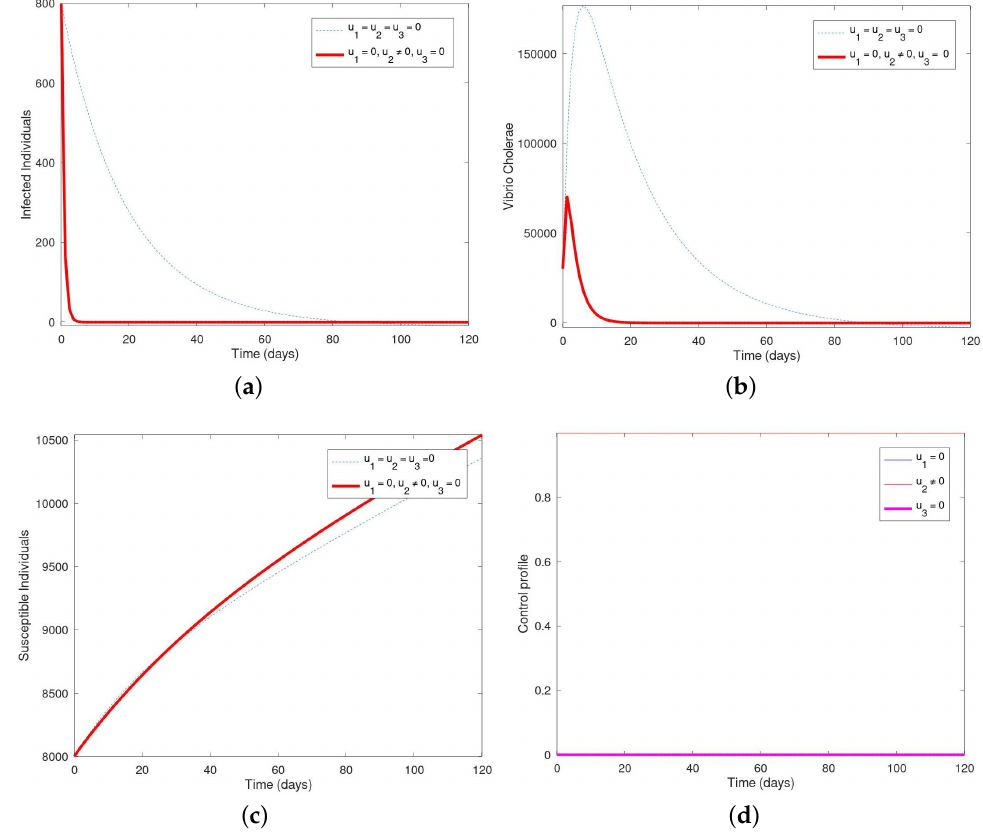
Figure 2. Simulation showing the population of ( a ) infected, ( b ) vibrio cholerae, ( c ) susceptible and ( d ) the control profile with ( u 2 ) , only. In Figure 2a, the population of the infected human decreases sharply and by day 20. Figure 2b showed that the population of vibrio cholerae increases slightly and then dropped from day 20 until the end of 120 days in the presence of the intervention. It was observed in Figure 2c that the population of susceptible human with the control intervention were more than the susceptible human without the control. The control profile in Figure 2d showed that the control u 2 , remained constant from day 1 till the end of the 120 days while the others ( u 1 and u 3 ) maintained lower